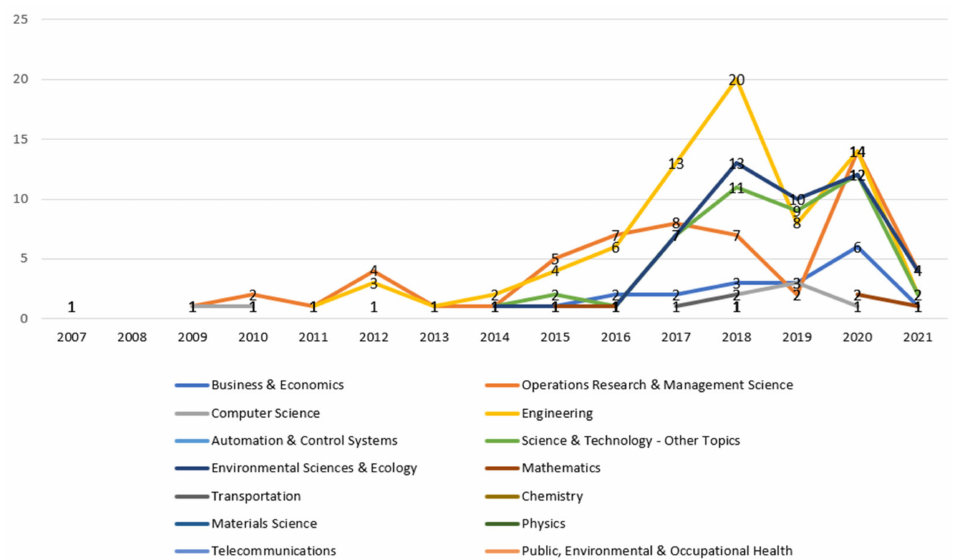
Figure 3. Progress of subject